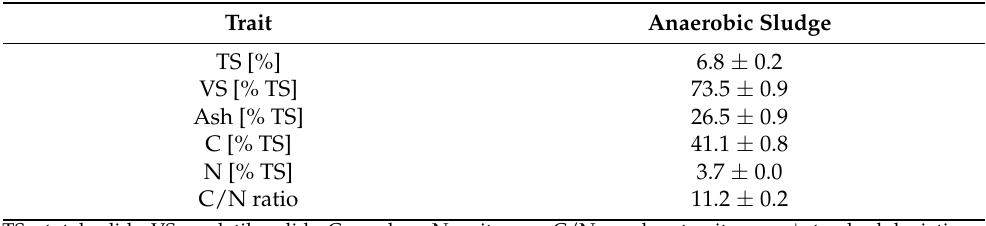
Table 1. The parameters of anaerobic sludge used as inoculum.